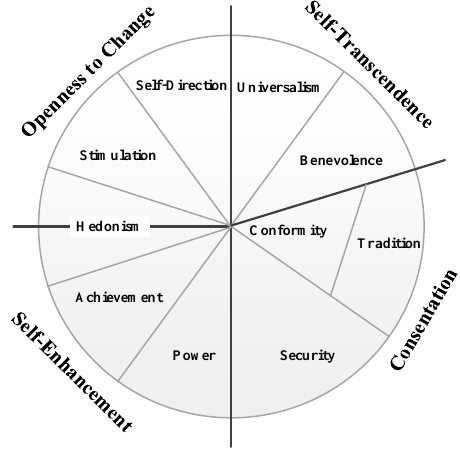
Figure 1. Schwartz Value Survey circumplex.